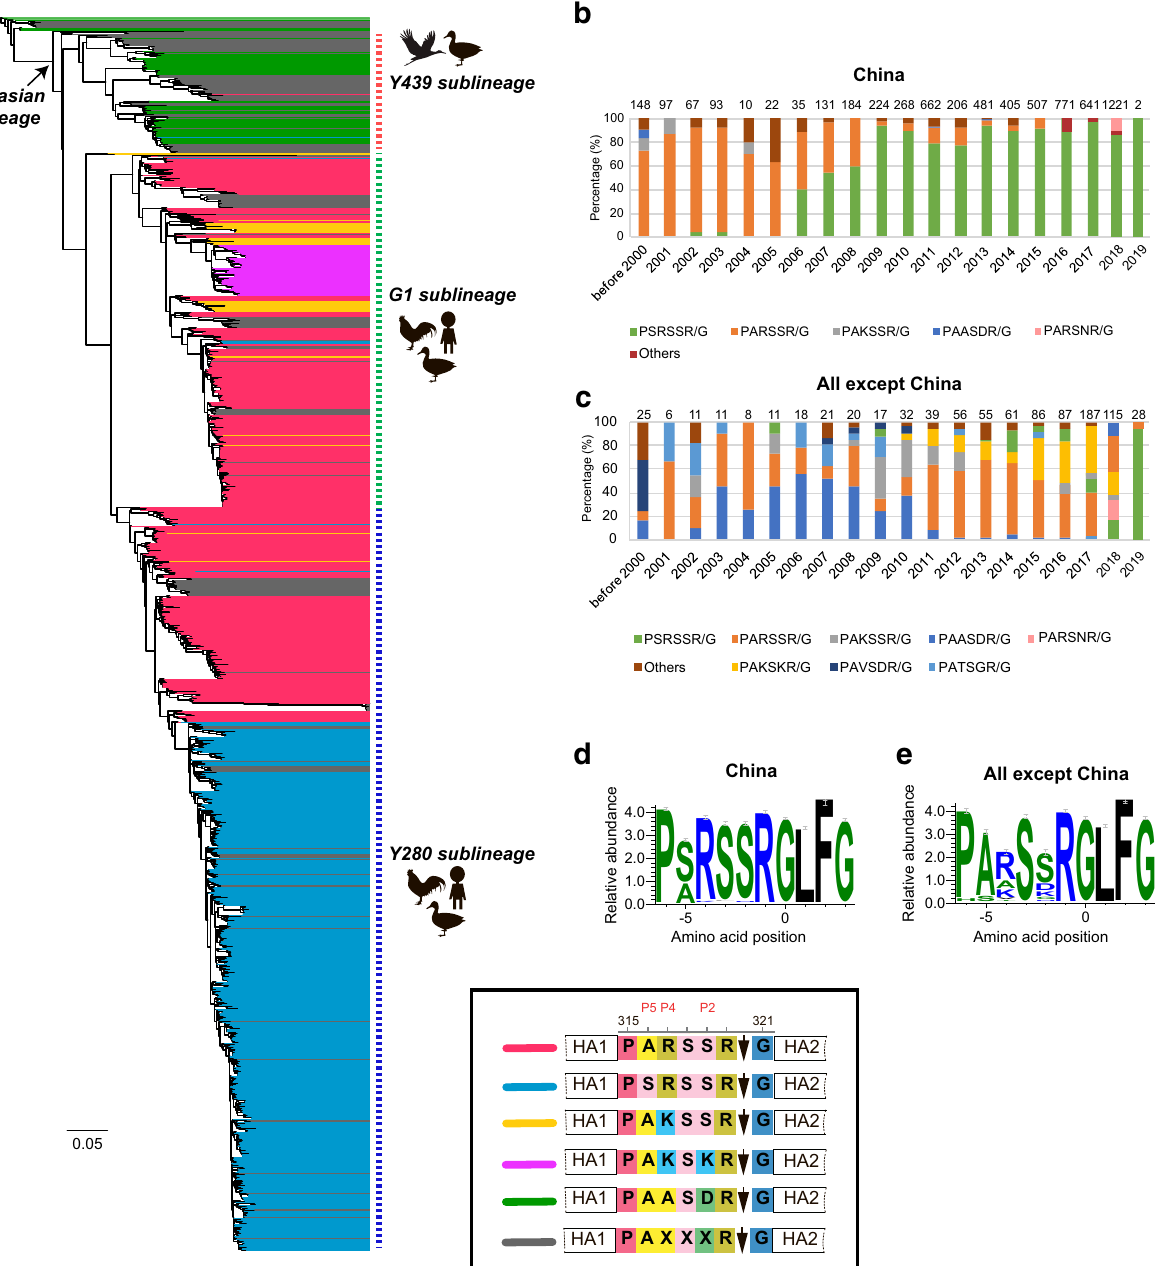
Fig. 1 Evolutionary history of HACS of the in fl uenza A(H9N2) viruses. a Maximum likelihood (ML) phylogeny of the H9N2 in fl uenza virus HA gene. The HA gene sequences from all available H9N2 viruses were downloaded from GISAID ’ s EpiFlu Database for phylogenetic analysis. The ML tree was inferred with the RAxML software under the GTRGAMMA model with 1,000 bootstraps. References H9N2 viruses from each HACS motif are denoted by different colors. The distribution of different HACS motif of in fl uenza A (H9N2) viruses from GISAID ’ s EpiFlu and GenBank Database. The branch length is scaled according to the numbers of substitutions per site (subs/site). b represents the distribution of the amino acids of HACS except for China, and c represents the amino acids of HACS in China. Different colored bars represent multiple HACS motifs of in fl uenza A(H9N2) viruses. Amino acids frequency of all available HACS of in fl uenza A(H9N2) viruses. Frequencies of each position, from P6 to P4 ’ of the HACS are illustrated using WebLogo 3.4 (http://weblogo.threeplusone.com/). d represents China, and e represents all countries except for